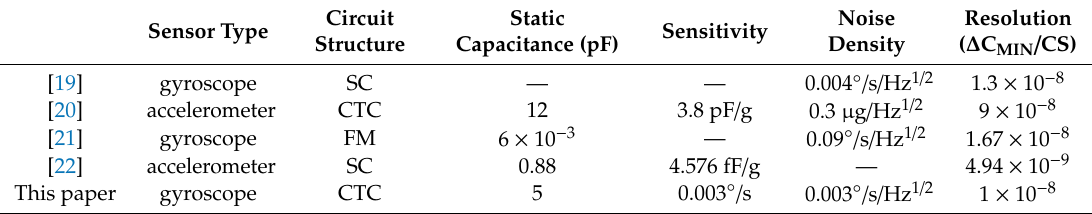
Table 2. Comparison of reported works of interface ASIC with this